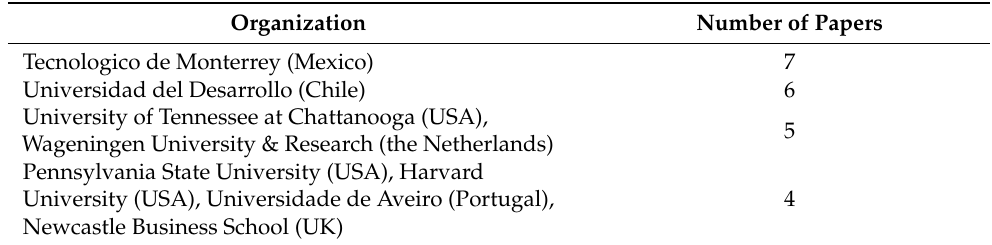
Table 2. Top influential institutions for social entrepreneurship and the entrepreneurial ecosystem. Source: own elaboration.